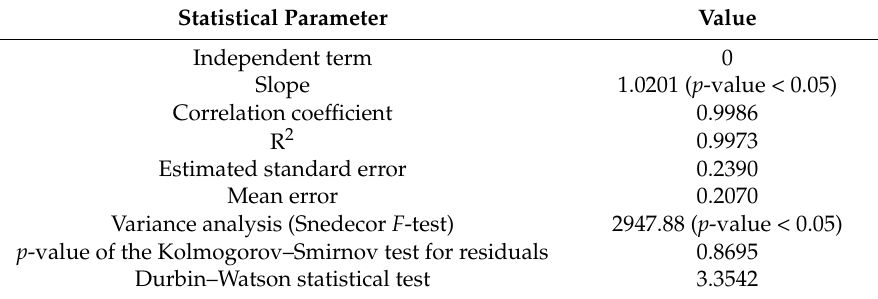
Table 9. Statistical analysis of mean UCS values of parts A and B from the same batch at 90